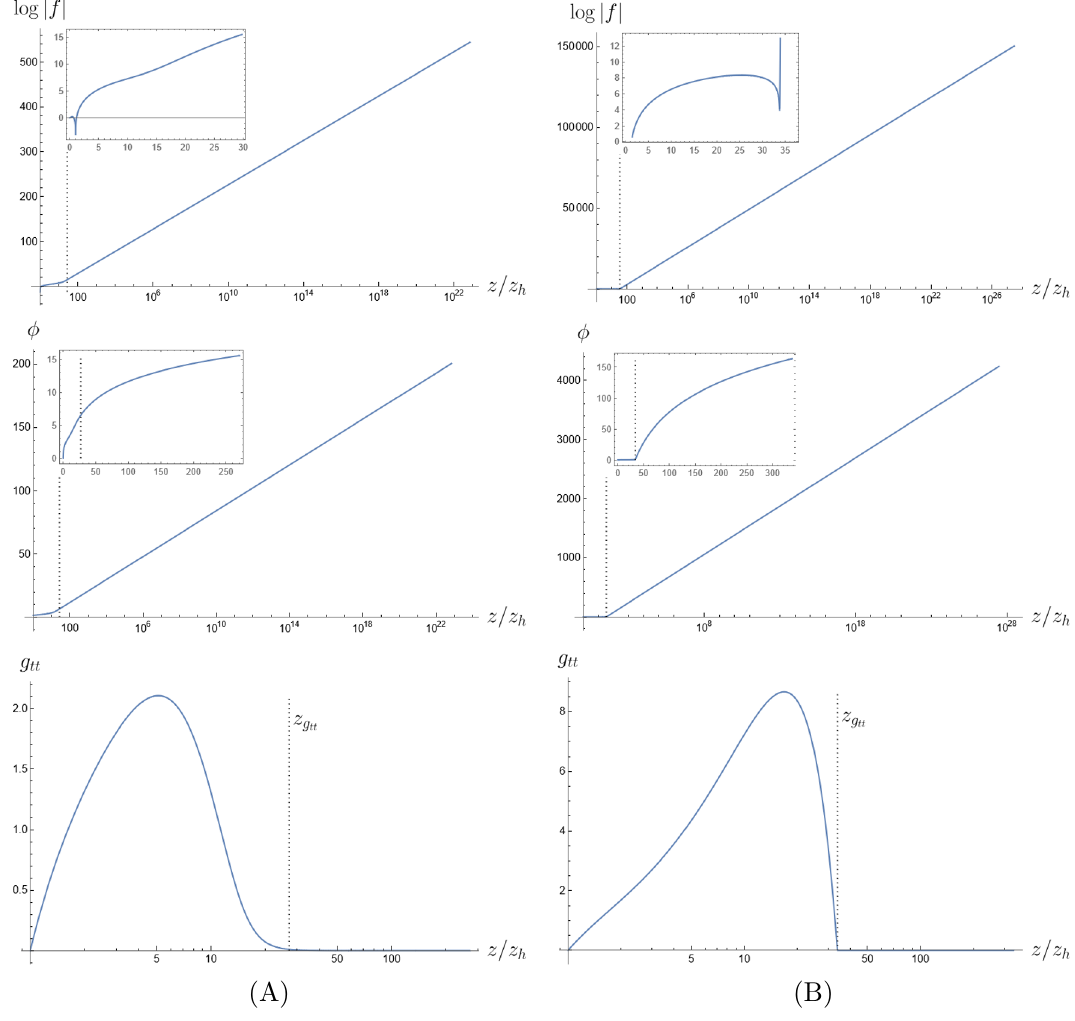
Figure 5 . Sample solutions for the neutral q = 0 case. For illustration purposes, we have chosen the values ( z h , ρ, φ h ) = (1 , 0 . 9 , 1 . 45) for (A) and (1 , 0 . 35 , 0 . 035) for (B), where the letters match the ones figure 4. The vertical dotted line is the “would be” Cauchy horizon z g